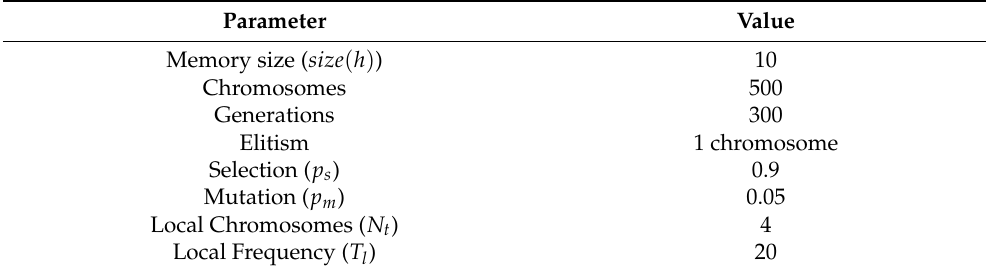
Table 4. Algorithm parameters